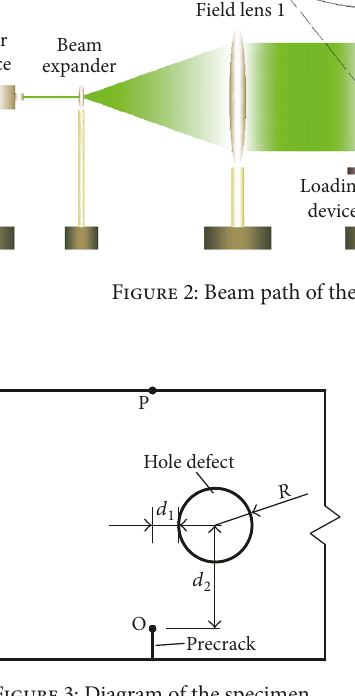
Figure 3: Diagram of the